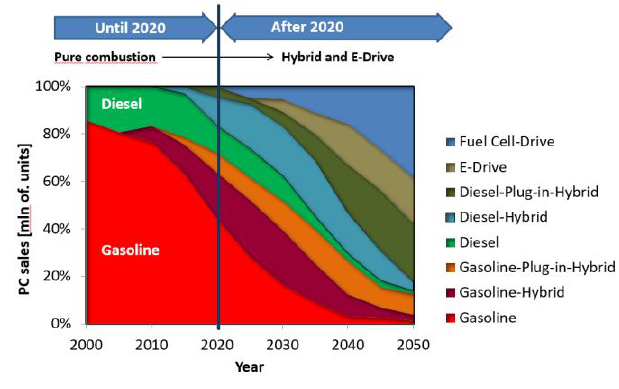
Fig. 3. Market share of various powertrains projected to 2050